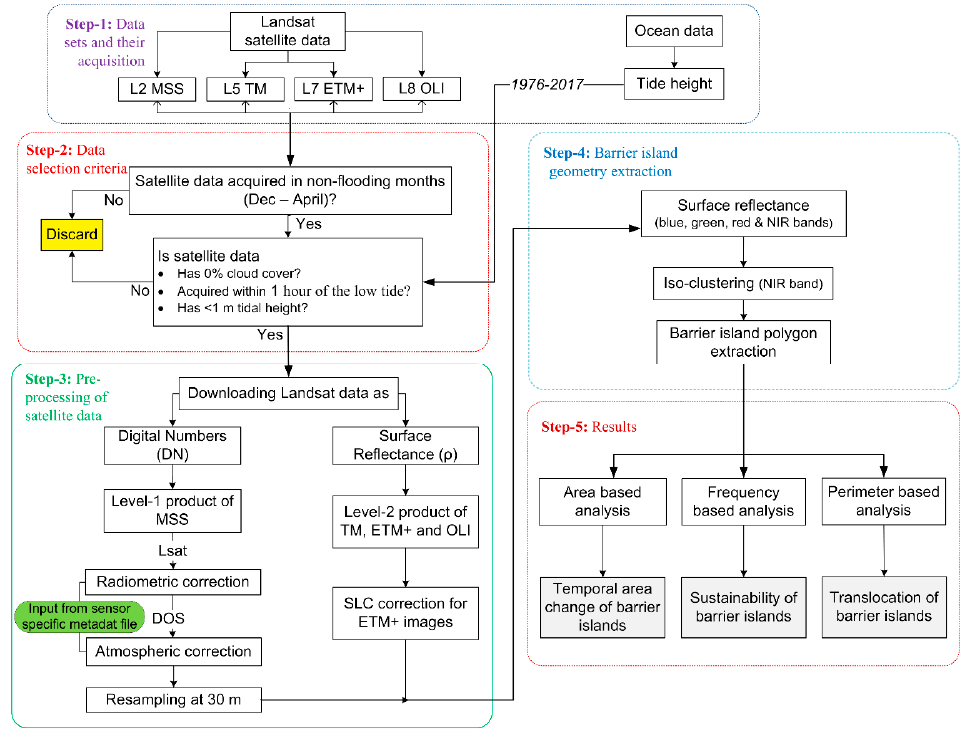
Figure 2. Flowchart of the methodology for the morphological change detection in the IDR barrier